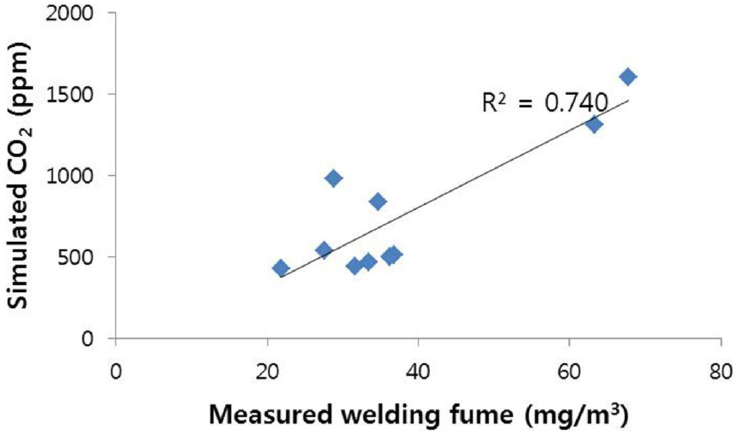
Figure 11. Correlation of simulated CO 2 and measured welding fume.